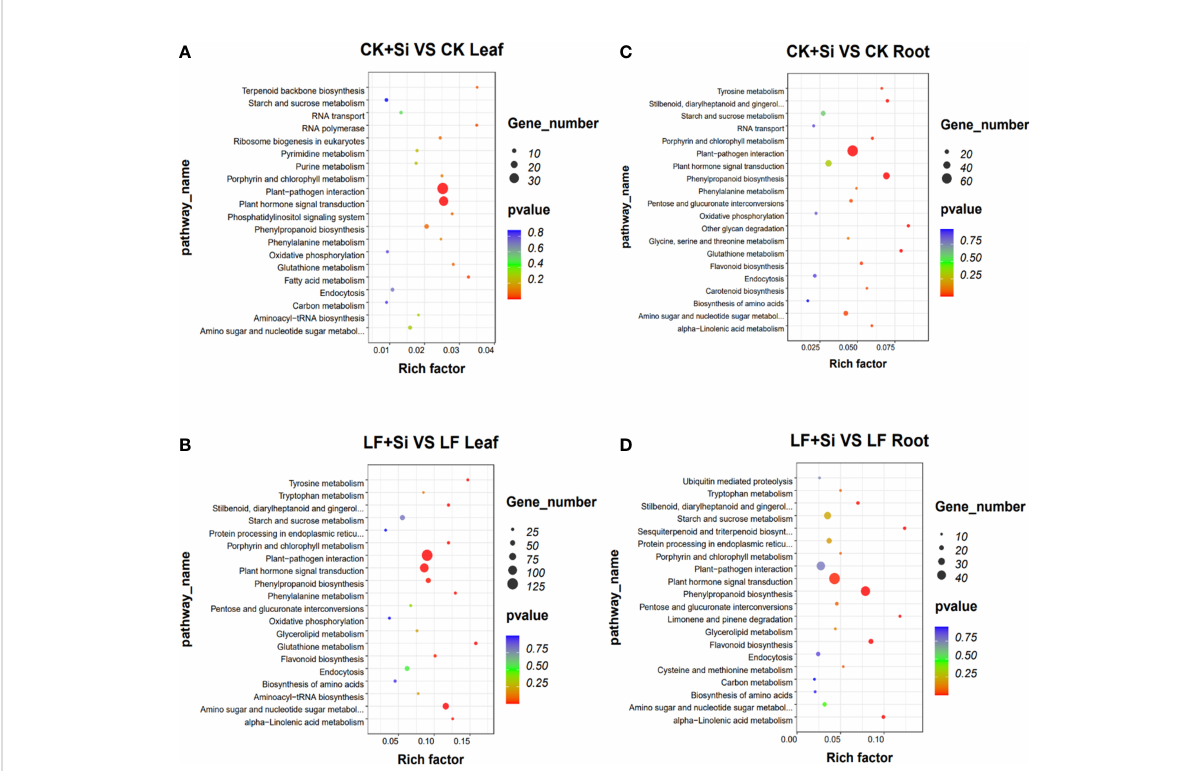
FIGURE 2 The KEGG enrichment analysis of differentially expressed genes. (A, B) The KEGG enrichment analysis in leaves. (C, D) The KEGG enrichment analysis in roots.